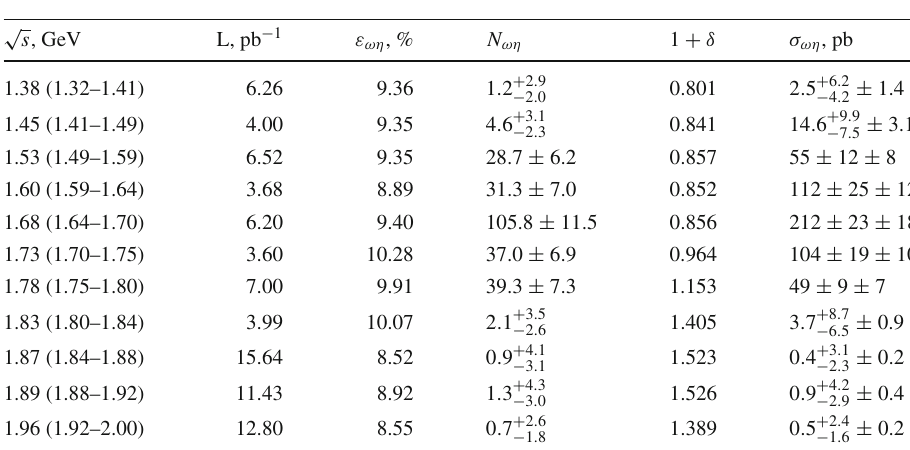
Table 3 The main sources of the systematic uncertainty on the measured e + e − → ωη and e + e − → rad- ηπ 0 γ cross sections, and the total e + e − → ηπ 0 γ cross section